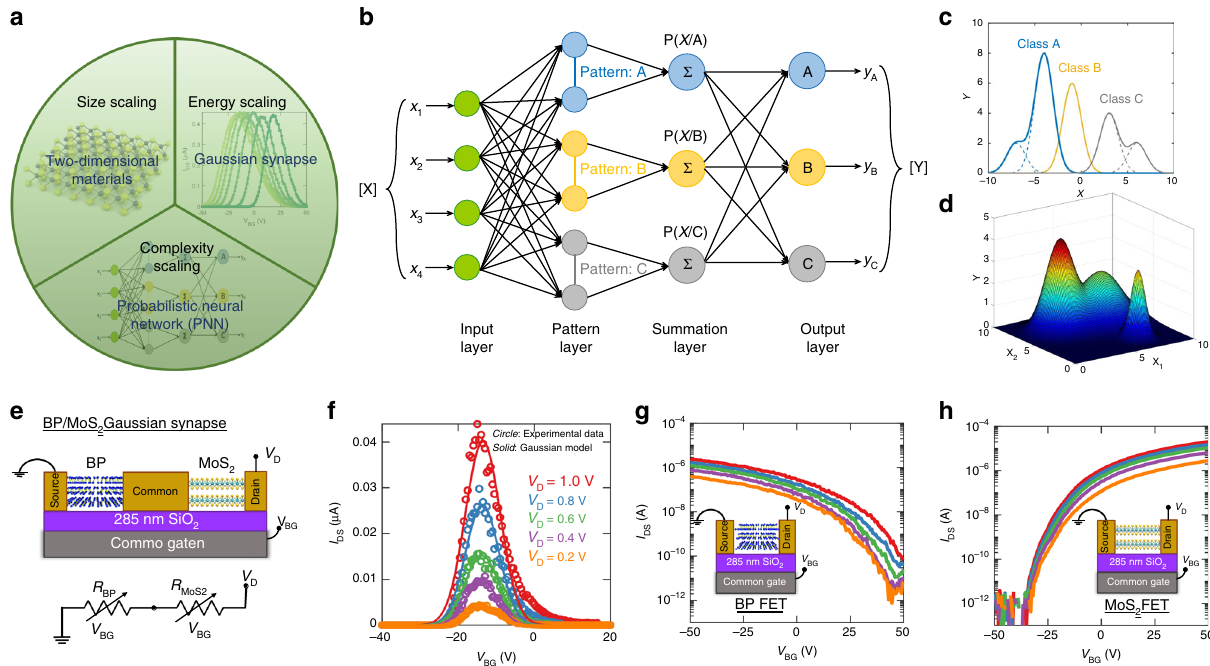
Fig. 1 Gaussian Synapse based probabilistic neural network (PNN). a Resurrection of three quintessential scaling aspects of computation i.e., complexity scaling through PNNs, size scaling through atomically thin 2D materials and energy scaling through analog Gaussian synapses. b Schematic representation of PNN that comprise of a pattern layer and a summation layer for mapping any input pattern to any number of output classi fi cations. c Gaussian probability density functions (PDFs) facilitating seamless and accurate classi fi cation of complex patterns with arbitrarily shaped decision boundaries. d Multivariate Gaussian kernel for mapping higher dimensional functions. e Schematic of two transistor Gaussian synapse based on heterogeneous integration of n-type MoS 2 and p-type black phosphorus (BP) back-gated fi eld effect transistors (FETs). The equivalent circuit diagram consists of two variable resistors connected in series. f Transfer characteristics i.e., the drain current ( I ) versus back-gate voltage ( V ) of the Gaussian synapse for D G different drain voltages ( V ). Clearly, the experimental data (circles) can be modeled by Gaussian distributions (solid). g Transfer characteristics of D